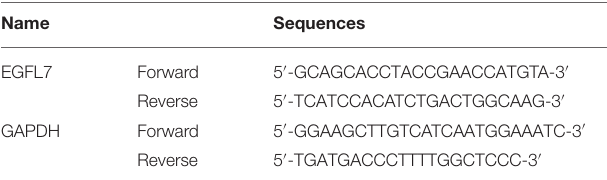
TABLE 1 | The primers used for